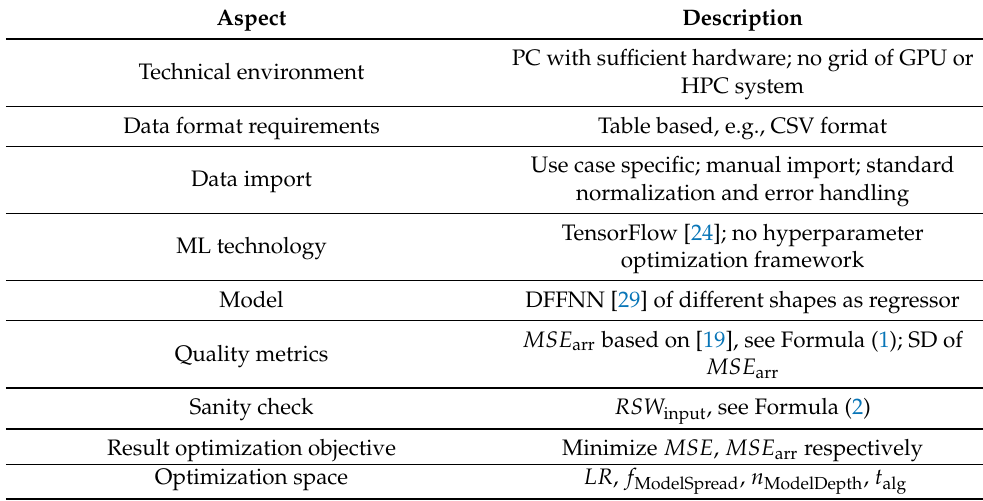
Table 2. ML Software Setup [Abbreviations: ML = Machine Learning; GPU = Graphics Process- ing Unit; HPC = High-Performance Computing; DFFNN = Deep Feed Forward Neural Network; SD = Standard Deviation; LR = Learning Rate].